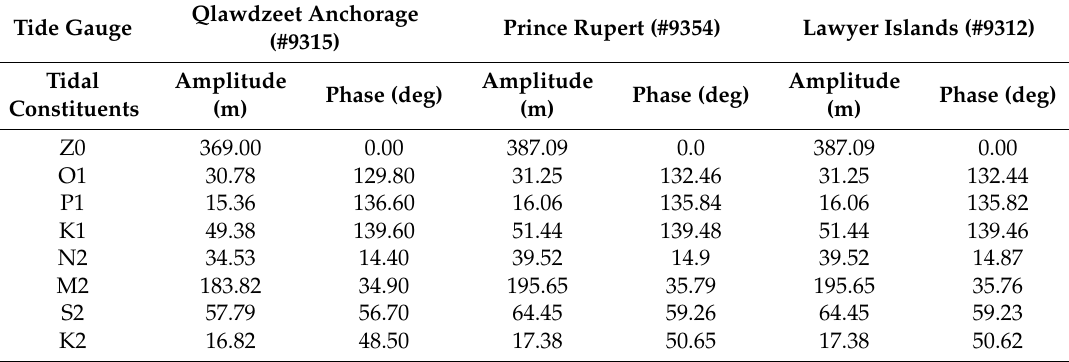
Table 1. Tidal constituents at tide gauge stations used for model open boundary